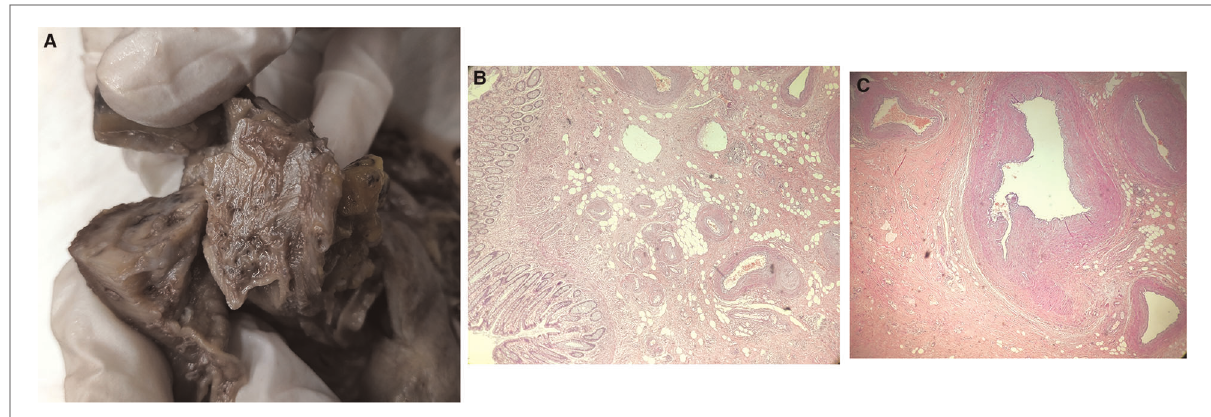
FIGURE 2 ( A ) macroscopic appearance of the polypoid AVM after fi xation. ( B ) hematoxylin and eosin large fi eld magni fi cation of the polypoid rectal AVM. ( C ) hematoxylin and eosin small fi eld magni fi cation of the polypoid rectal